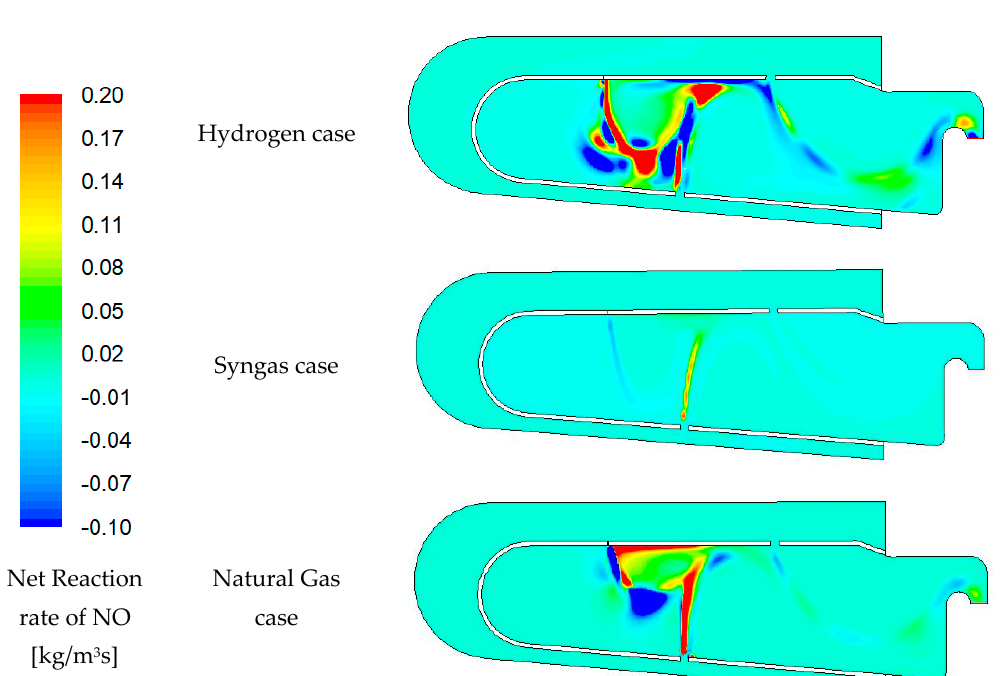
Figure 20. NO distributions in combustor.